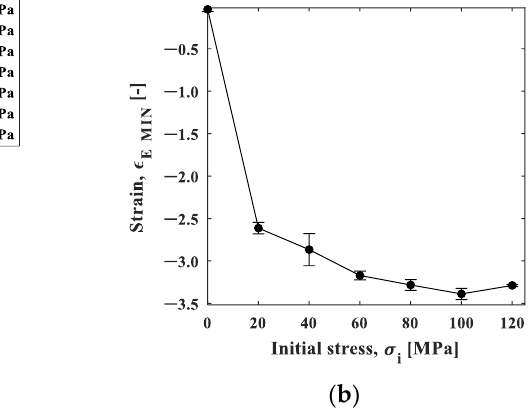
Figure 13. ( a ) Strain – time curve; and ( b ) strain – initial stress curve.